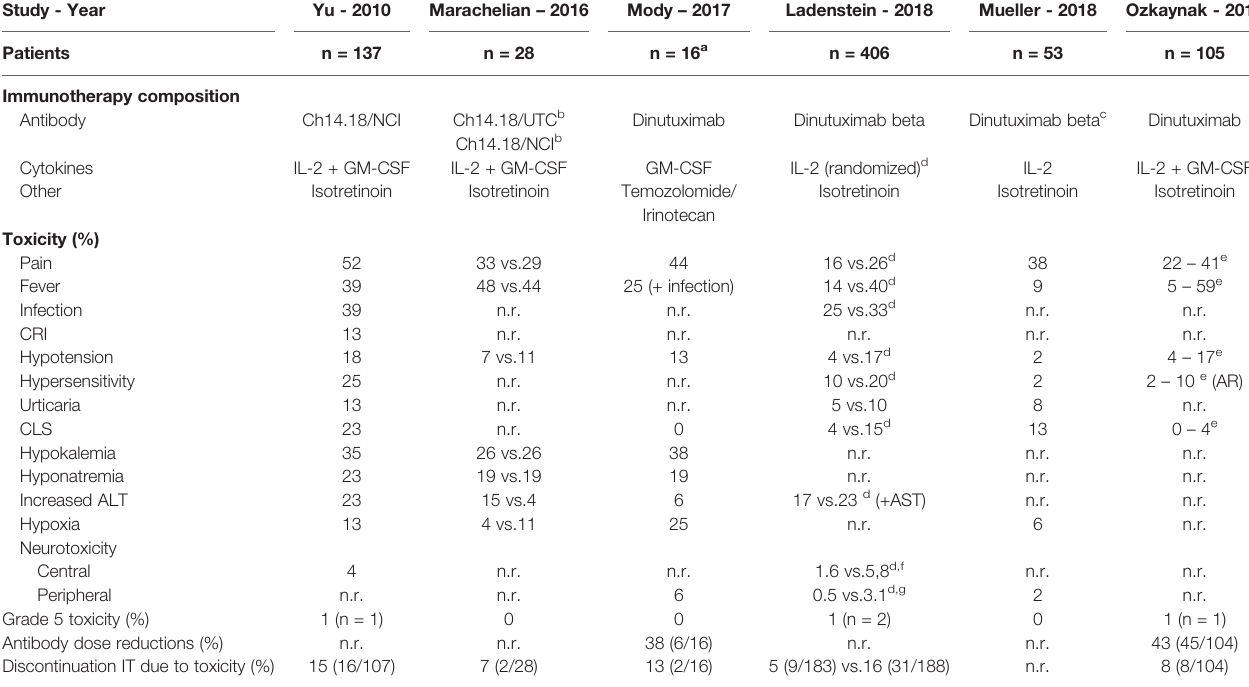
TABLE 1 | Literature overview of reported non-hematological immunotherapy-related grade ≥ 3